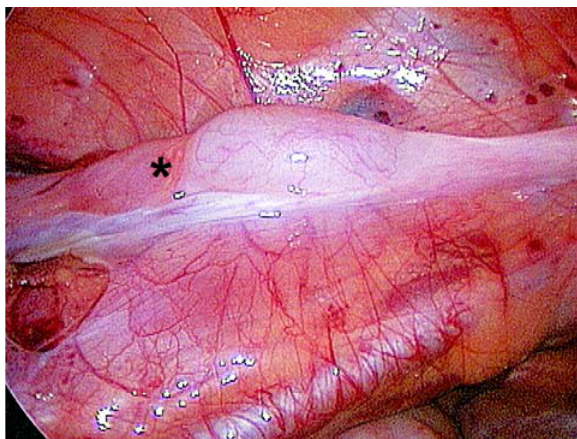
Figure 2 – Laparoscopic view of the left testicle where we ob- serve the epididymis head